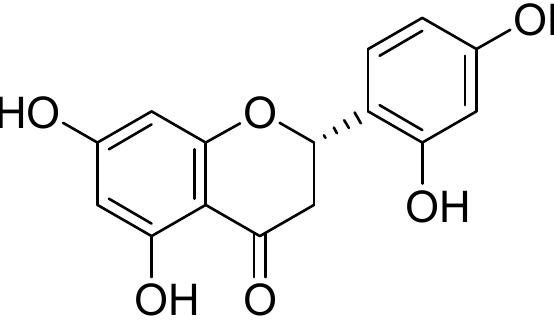
Figure 1. Chemical structure of steppogenin ( 1 ).